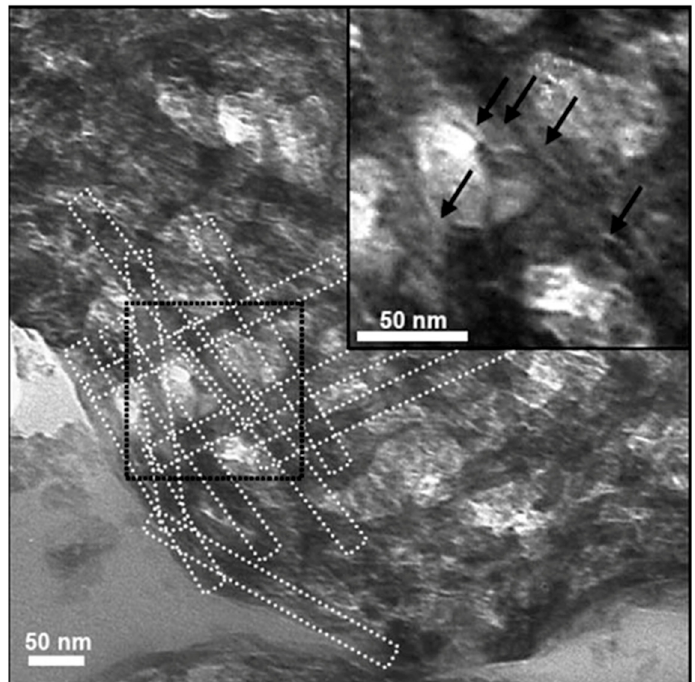
Figure 9. TEM analysis of spray-dried microparticles obtained with high initial chitin volume fractions [71]. The sample is formed by entangled rods of silica (white dashed rectangles) separated by voids (10–100 nm). These rods come from the initial chitin nanorods represented by the rectangles (23 × 260 nm 2 ). Inside the silica rods, the imprint of the chitin monocrystals (2–3 nm wide) can be distinguished (black arrows in the zoomed area)